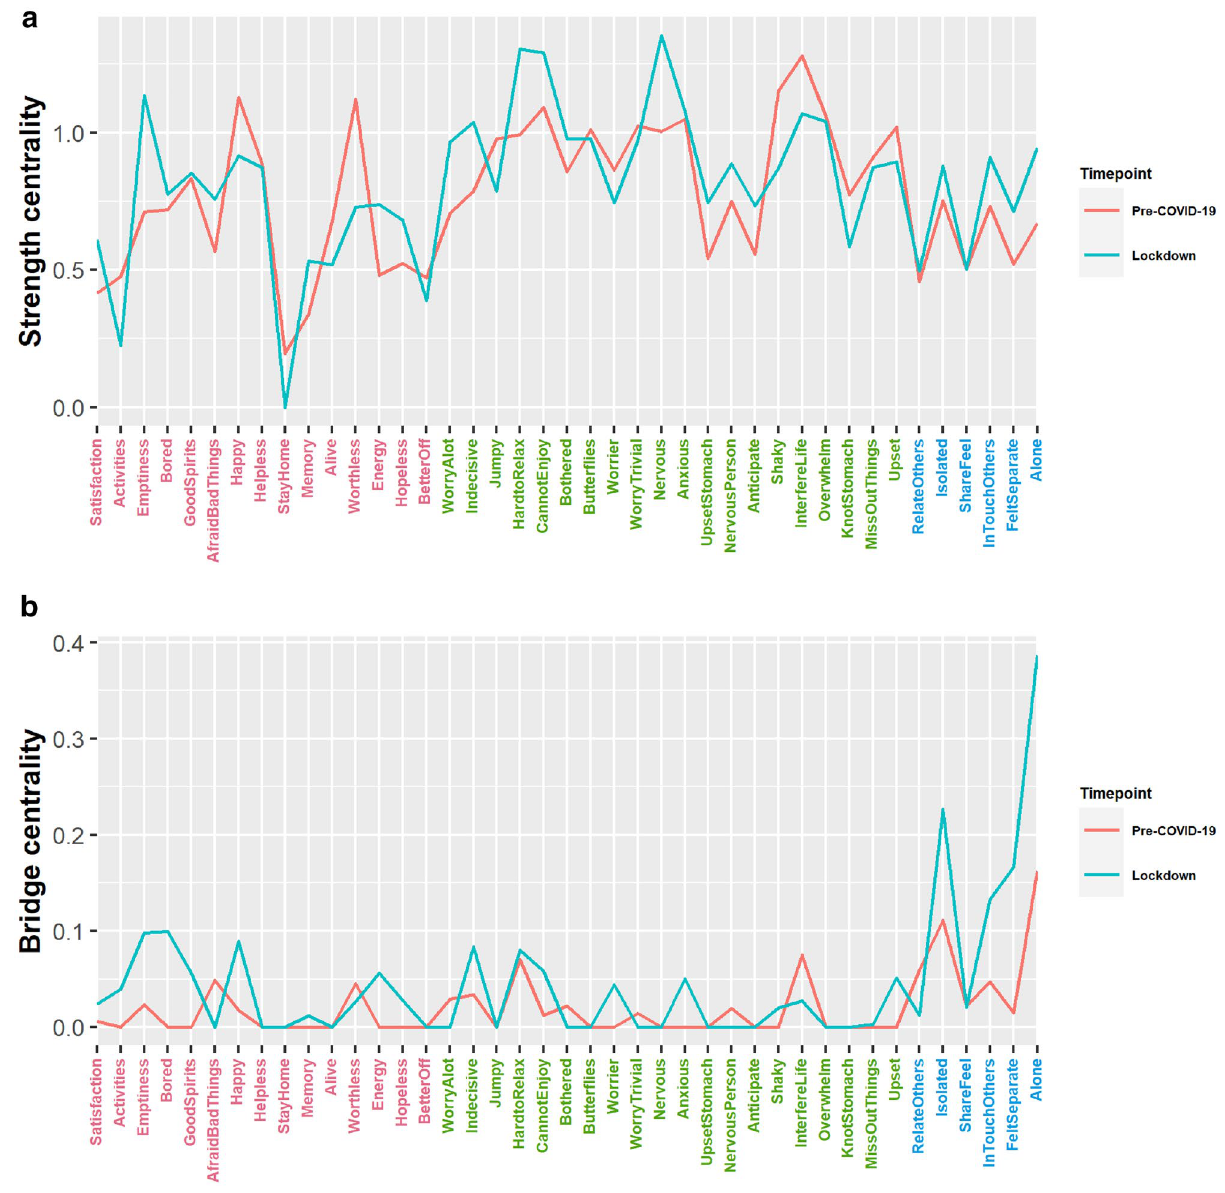
Figure 4.. ( A ) Strength centrality and ( B ) bridge centrality of all nodes across both time points. The red, green and blue axis labels correspond to the items from the geriatric depression scale, geriatric anxiety inventory and the friendship scale,